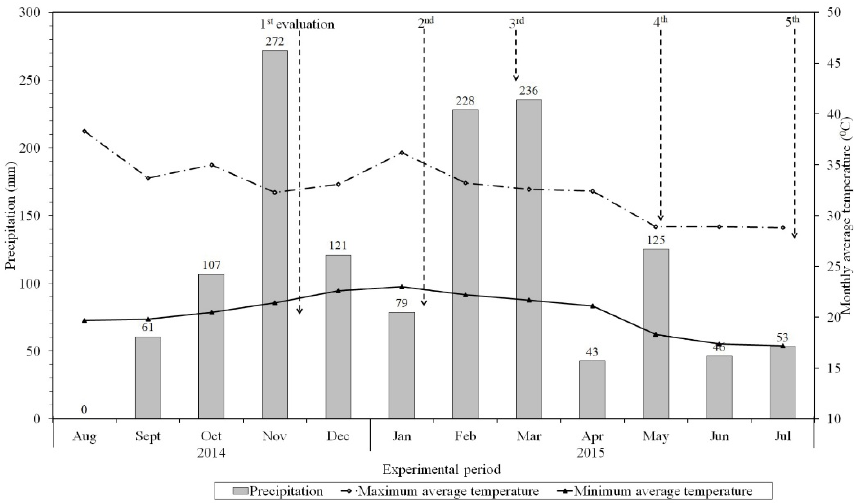
Figure 1. Monthly averages of pluvial precipitation and minimum, maximum and average temperatures, as well as evaluation timings during the experimental period.